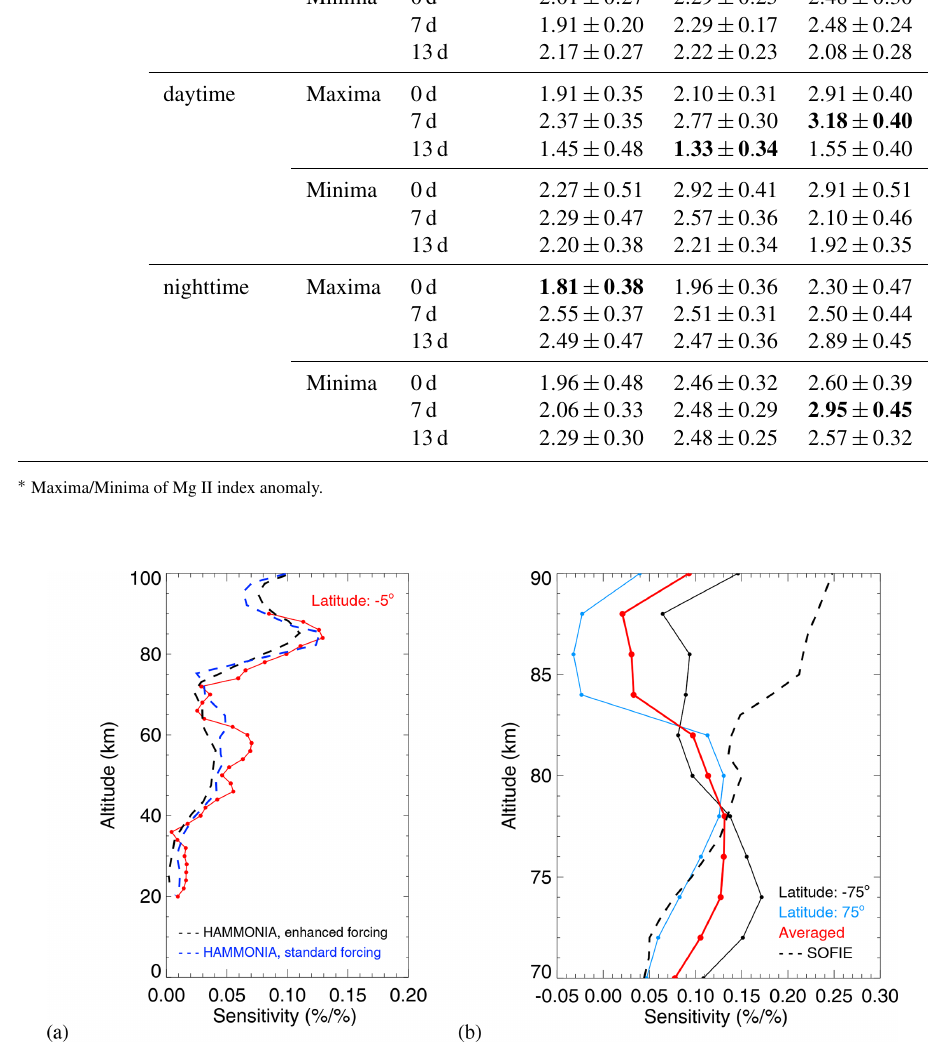
Figure 14. (a) MLS temperature sensitivity profile (red line) (sensitivity expressed as % change in temperature per % change in solar UV flux at 205nm) for a latitude of 5 ◦ S and altitudes ranging from 20 to 90km for the daily averaged temperature data from 2005 to 2017. The profile is from Fig. 13a. The dashed lines are the sensitivity results from HAMMONIA for enhanced forcing (black) and for standard forcing (blue) calculated by Gruzdev et al. (2009). (b) Similar to (a) , except for the southern summer and a latitude of 75 ◦ S (solid black line) and for the northern summer and a latitude of 75 ◦ N (blue line) for altitudes from 70 to 90km. The sensitivity profile ( solid black line) is from Fig. 11c. The sensitivity profile (blue) is from Fig. 11d. The red profile is the averaged sensitivities of the black and blue profiles. The dashed black line is the sensitivity results based on SOFIE data from Thomas et al.